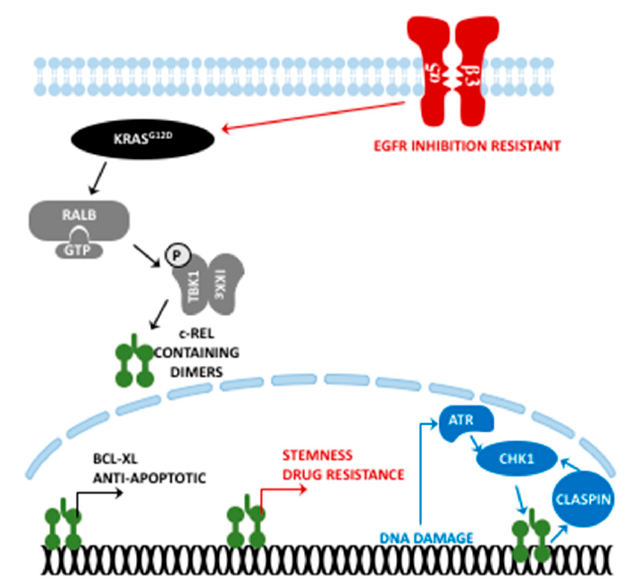
Figure 2. Functions of c-Rel in pancreatic cancer. Although some of these pathways still need to be confirmed in PDAC, similarities are expected. Each color represents a different signaling axis. P: Phosphorylation.